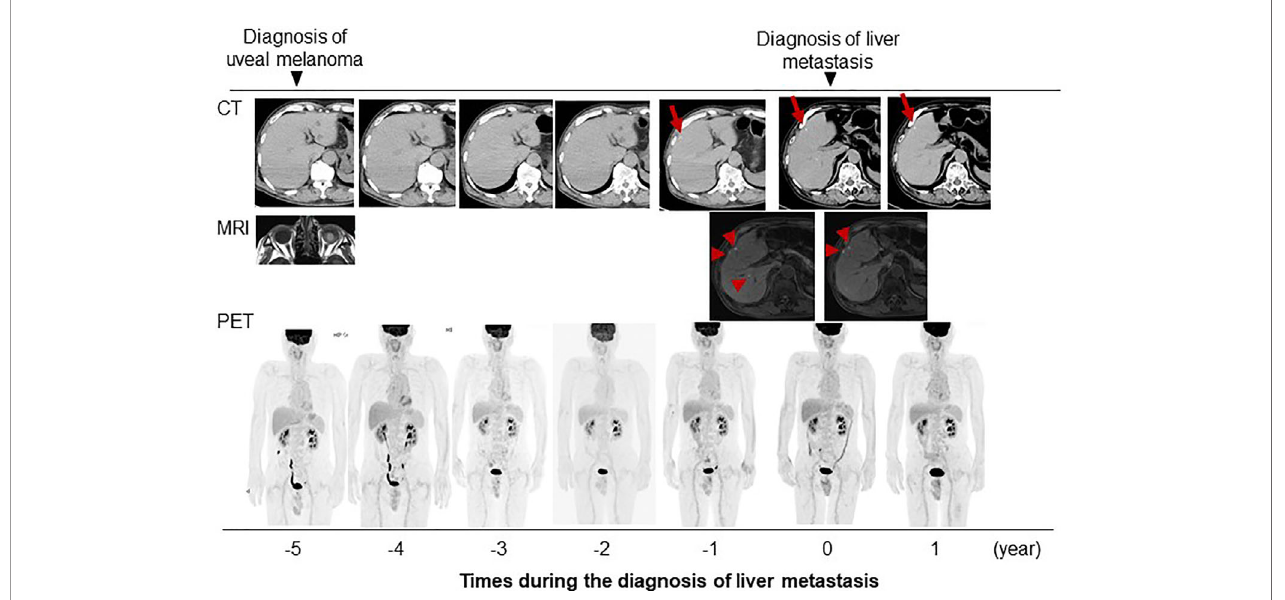
FIGURE 4 | Clinical course of present case with images. Red arrow and arrow head indicate the metastatic tumors detectable with imaging